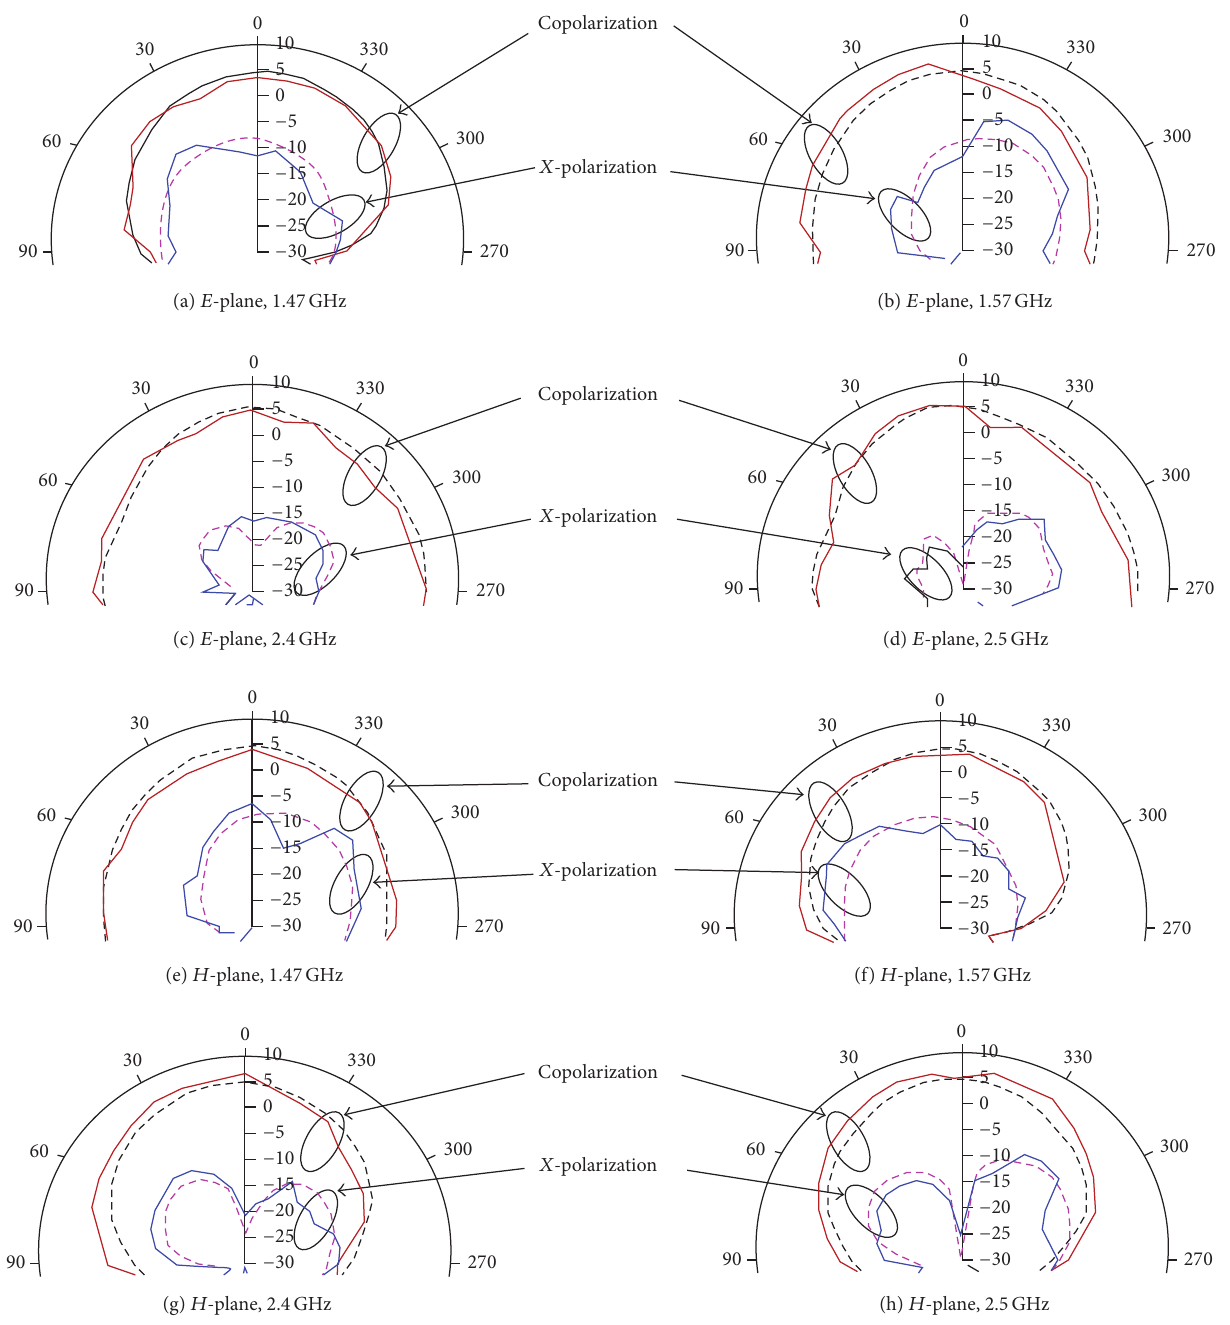
Figure 14: Simulated and measured copolarization and cross-polarization radiation patterns: black long dash, simulated copolarization; brown solid line, measured copolarization; pink short dash, simulated cross-polarization; blue solid line, measured cross-polarization.